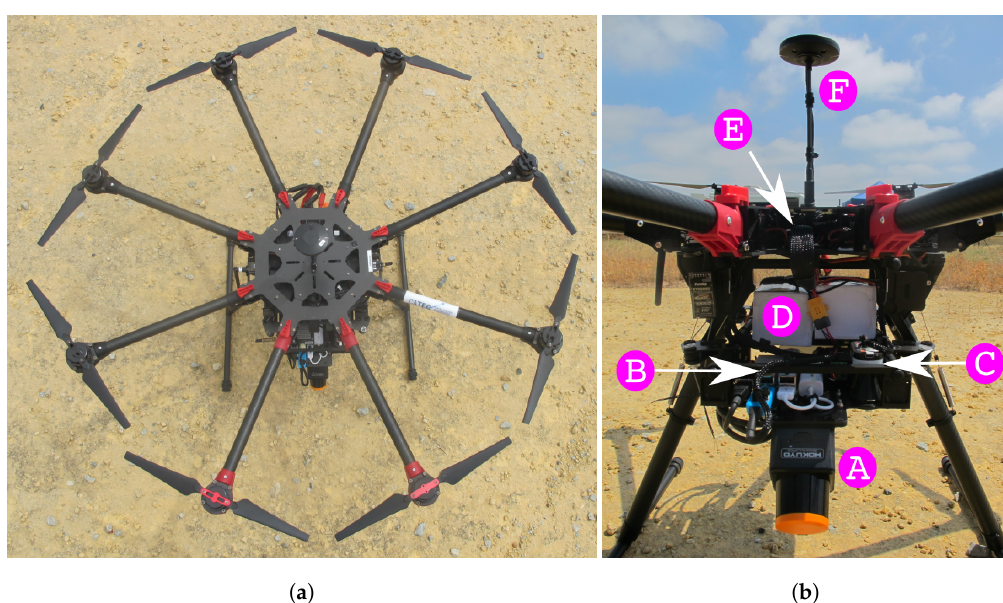
Figure 3. The UAV used in outdoor flights as seen from above ( a ) and from the side ( b ). The platform is a DJI S1000 and consists of one Hokuyo 10Lx sensor (A), an UpBoard with an Intel R (cid:13) Atom TM x5 (B),